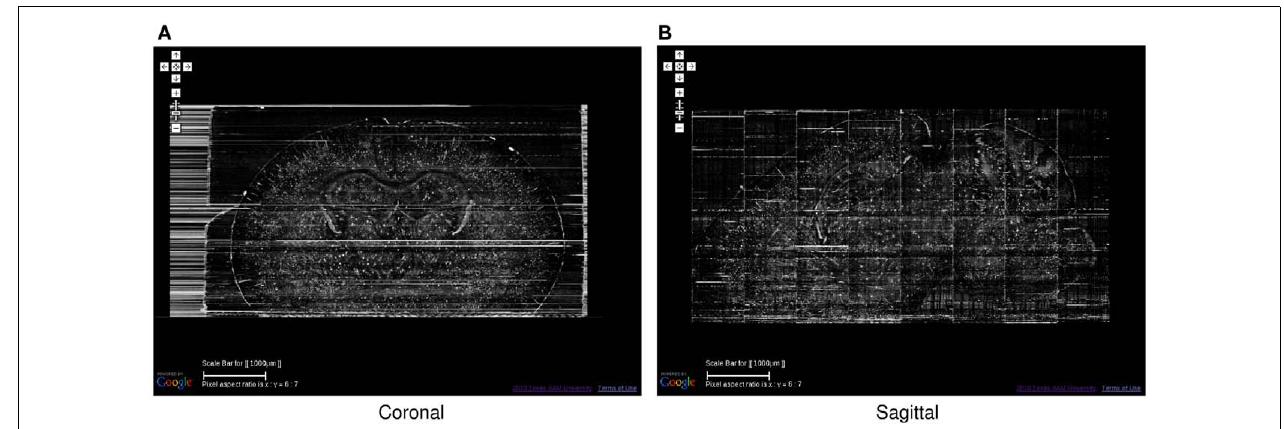
FIGURE 7 | Golgi data set 2, Coronal and SagittalViews. The coronal (A) and sagittal (B) views of the data set in Figure 6 are shown. Scale bar = 1mm. These views show the superior z -axis resolution of the KESM data sets.